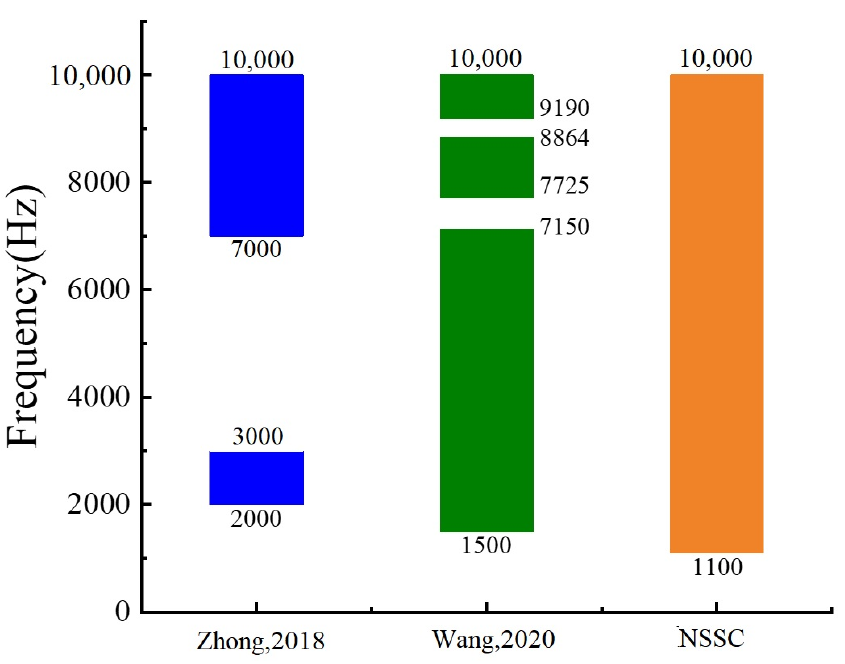
Figure 15. Comparison of absorption bandwidths with absorption coefficients above 0.8 between NSSC and other UALs in representative references [27,28].